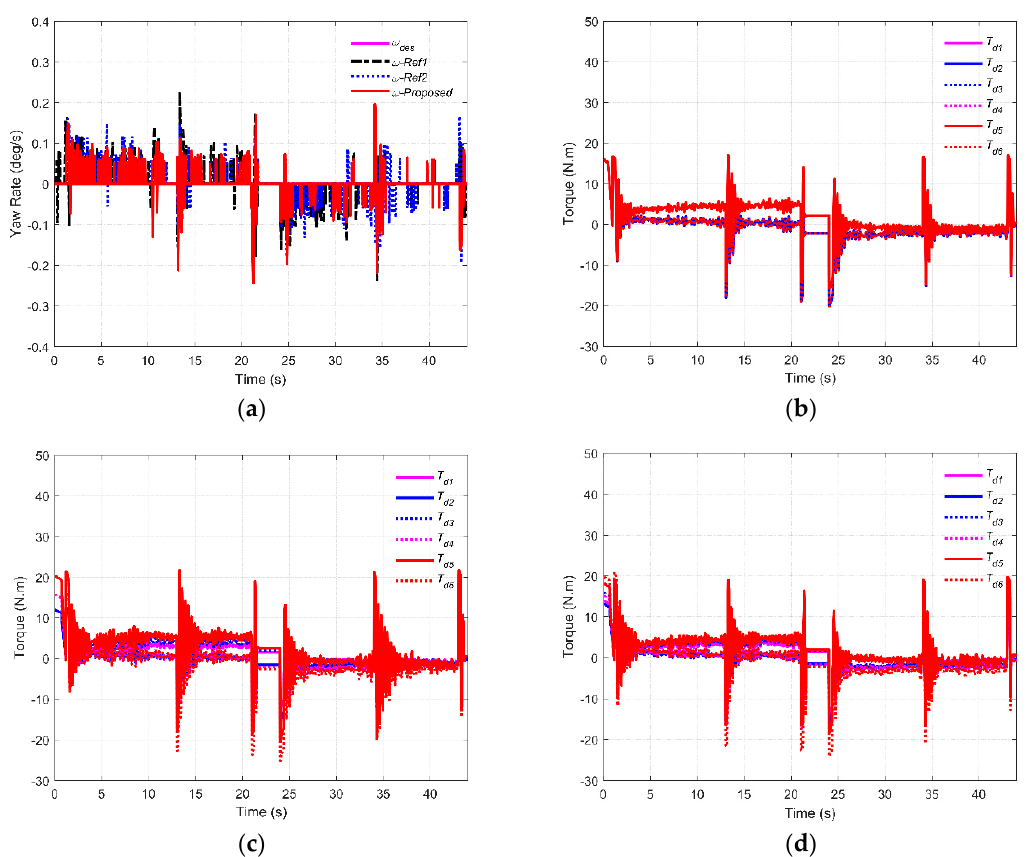
Figure 9. Comparison of yaw rate and the desired torque on each wheel with three controllers: ( a ) Comparison of yaw rate; ( b ) Torque on each wheel with Ref1 controller; ( c ) Torque on each wheel with Ref2 controller; ( d ) Torque on each wheel with the proposed controller.